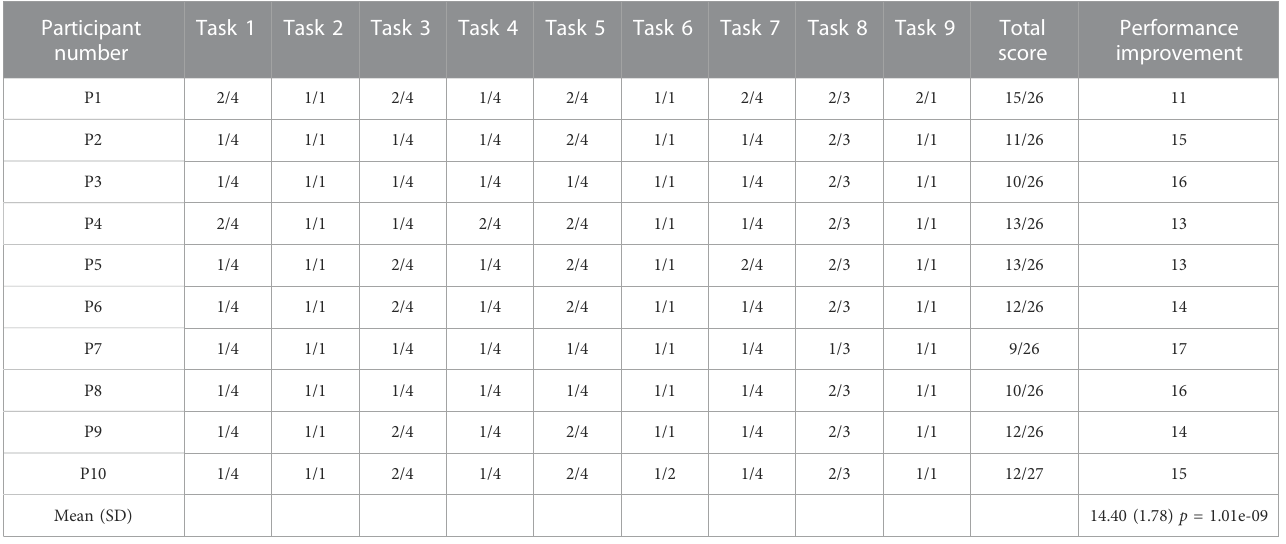
TABLE 3 Task-based functional assessment results.